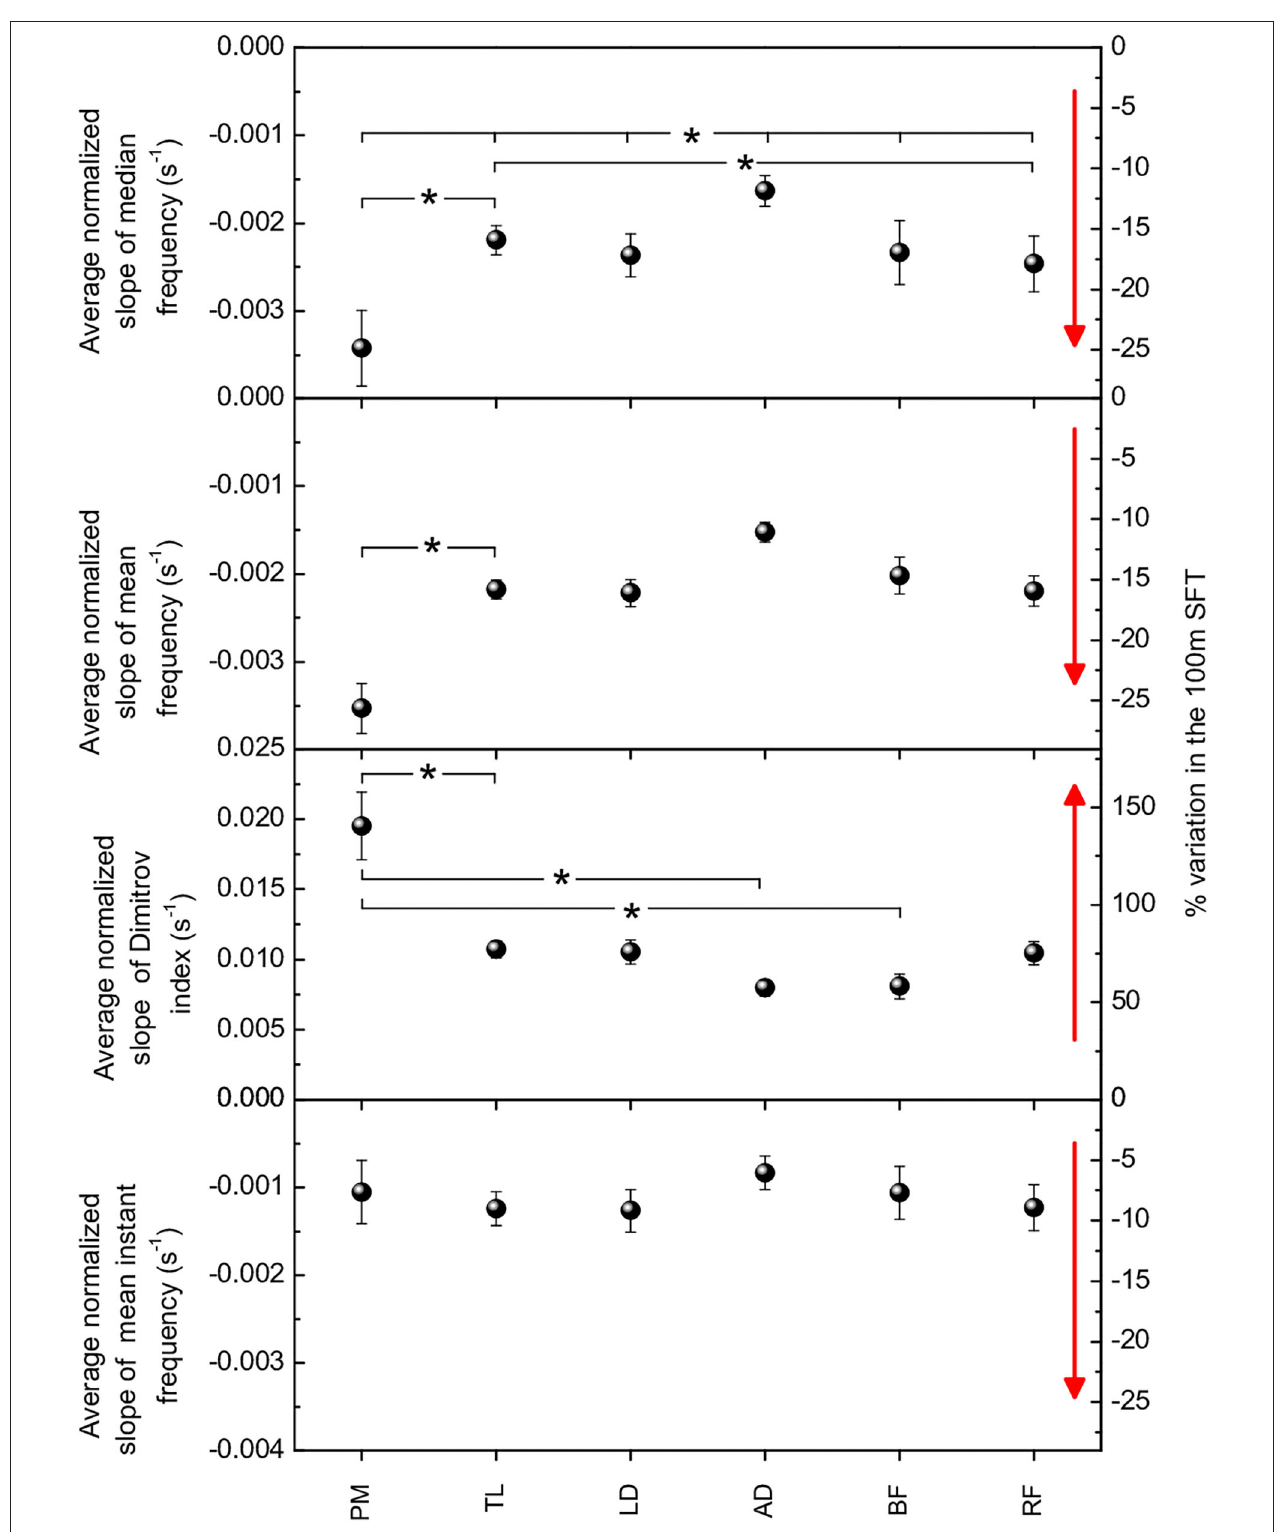
FIGURE 4 | Weighted averages of the normalized slopes of spectral parameters for the six muscles. Panels from top to bottom: F med , F mean , DI, F mi . All these values are statistical significant ( p < 0.0001). Right-hand axes indicate the percent variation in the FST. Asterisks indicate statistical significance ( p < 0.05) of difference between either two or all six muscles. Red arrows point to the direction of increasing fatigue for each spectral parameter.